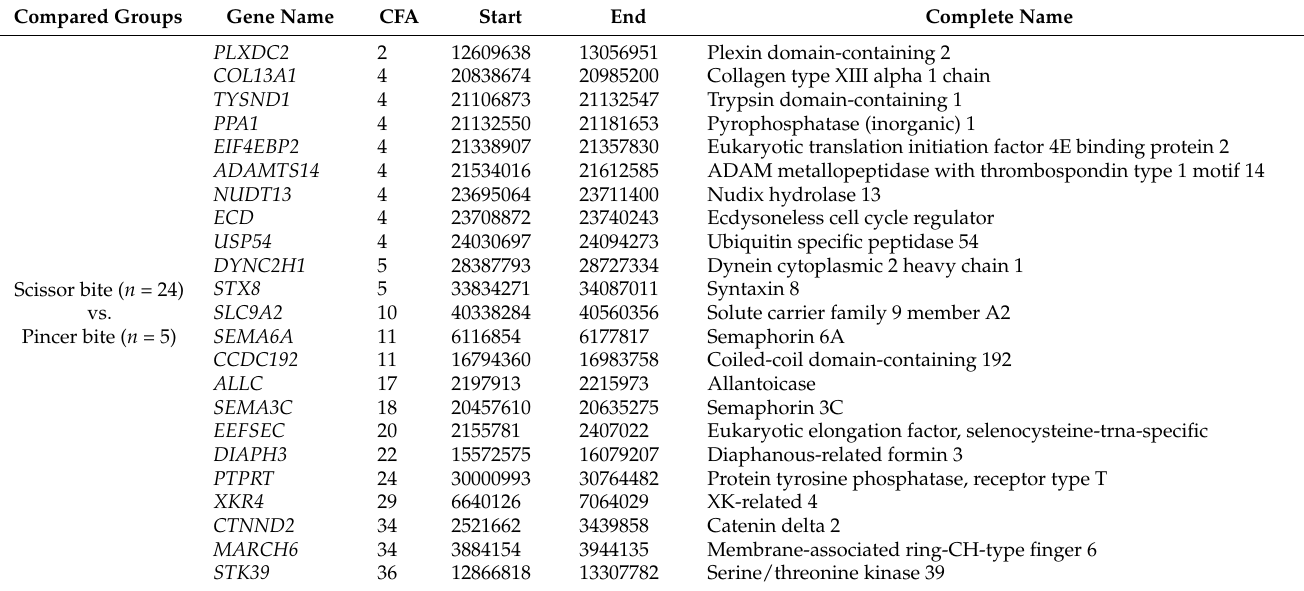
Table 1. Genes identified by both F ST and XP-EHH analyses comparing Fonni’s dogs with different phenotypes.